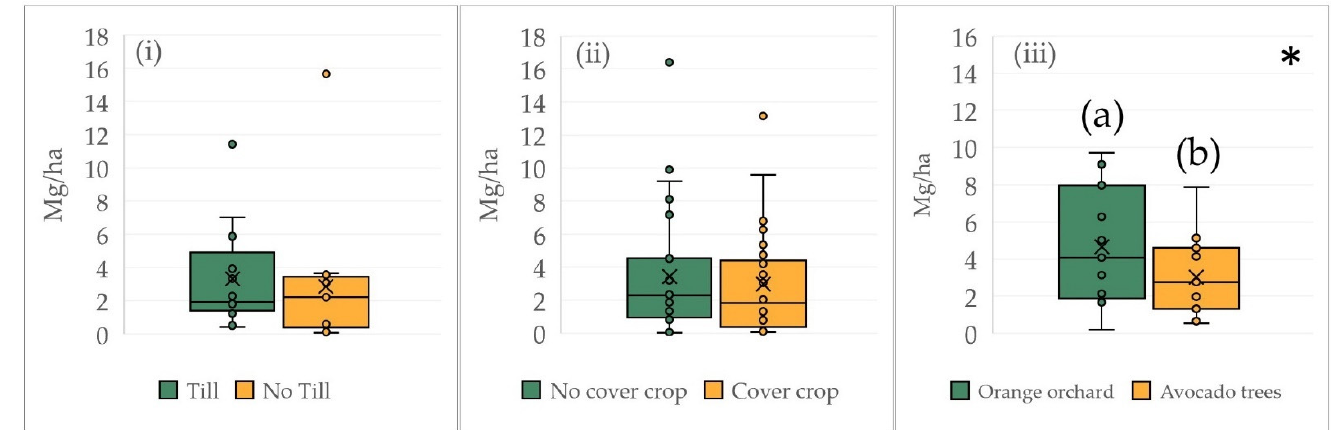
Figure 4. Mean soil erosion (Mg/ha) in ( i ) tilled and non-tilled plot at the olive orchard site during the 2.5-year of monitoring, ( ii ) no vetch and vetch plot at the vineyard site during the 2.5-year of monitoring, and ( iii ) orange and avocado plot at the fruit orchard field during the 3-year monitoring (* denotes significant differences at a 90% CI level).